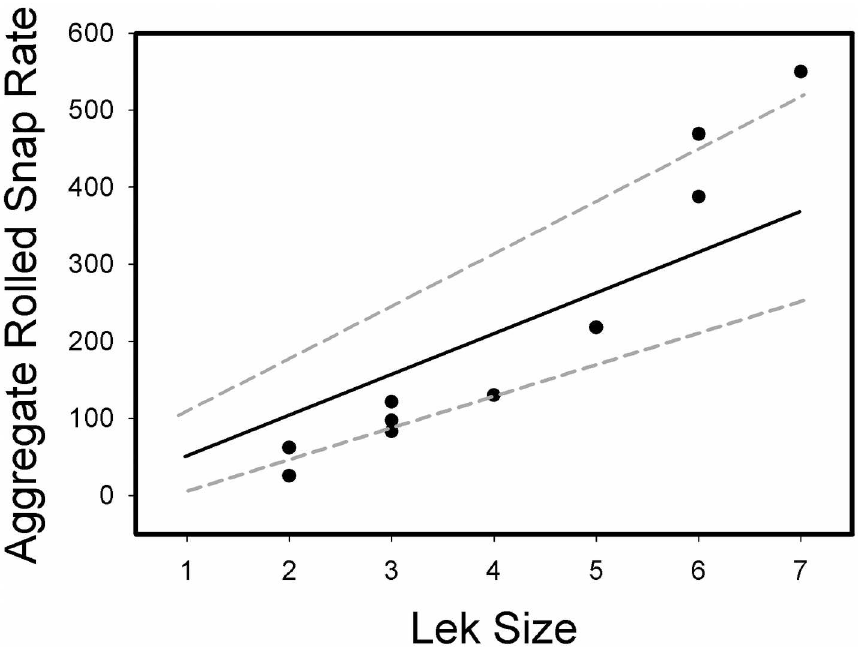
Fig 5. Observed aggregate rolled snap rate (#/h)at each of 10 M . manacus leks are shown as solid circles. The mean (solid line)and 95% confidence intervals (dashedlines) for aggregaterolledsnap rates calculatedfromresampling(n = 999 times)are also shown. Values above the dashed line reflectgreater display rate than expected, while those below represent relatively lower display rate than expected.